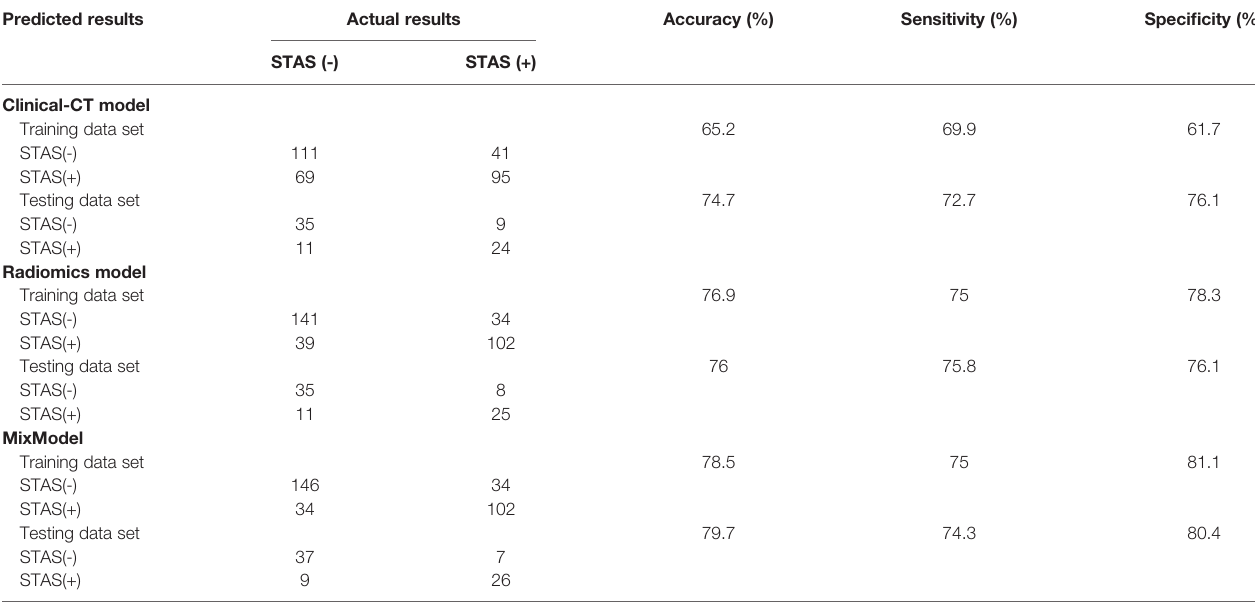
TABLE 6 | Confounder matrix for the training and testing sets in the three models. Predicted